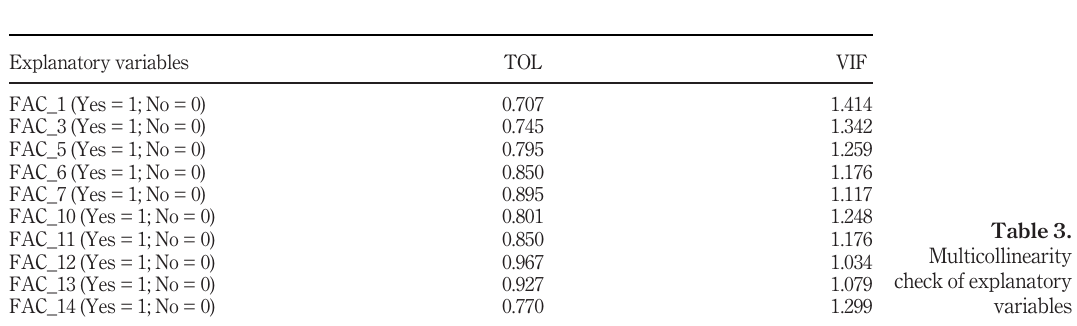
Figure 3. Frequencies of each severity level of accidents